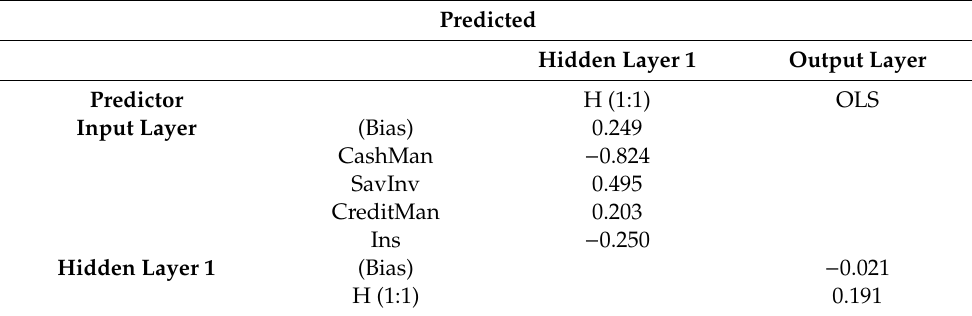
Table 4. Parameter estimates for Model B (calculated by the authors).